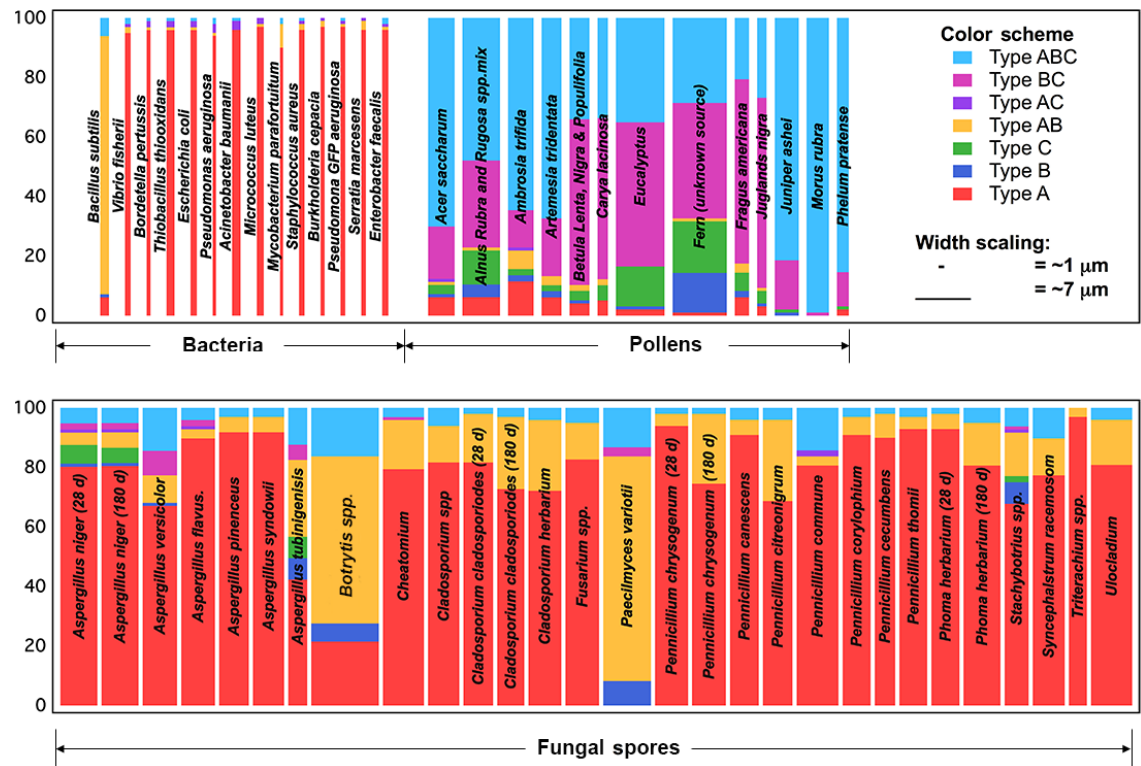
Figure 2. Juxtaposition of optical and fluorescence properties of aerosolized pure cultures of bacteria and pollens (top), and fungal spores (bottom). Fluorescence type distribution is defined by excitation and emission from any of three possible channels alone (A, B or C) or in any combination. Bar width is proportional to equivalent optical diameter (scaling shown below color scheme legend in top